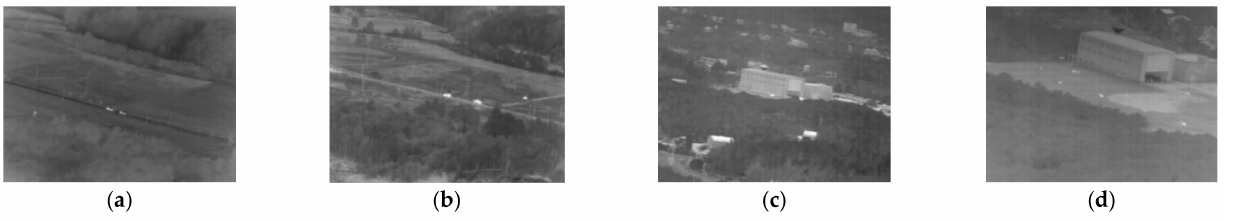
Figure 1. Dataset partial image example. ( a ) Single target. ( b ) Multi-target. ( c ) Single target in complex environment. ( d ) Multi-target in complex